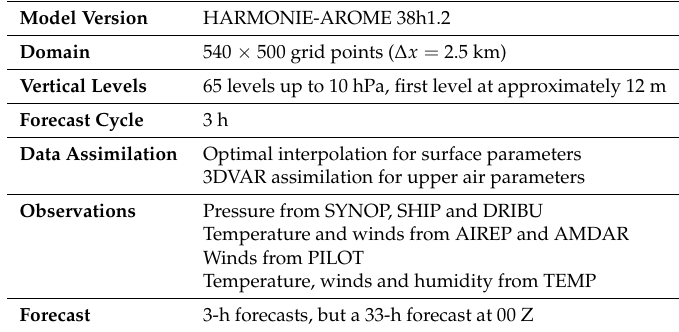
Table 1. HARMONIE-AROME configuration used for MÉRA. SYNOP, synoptic station .